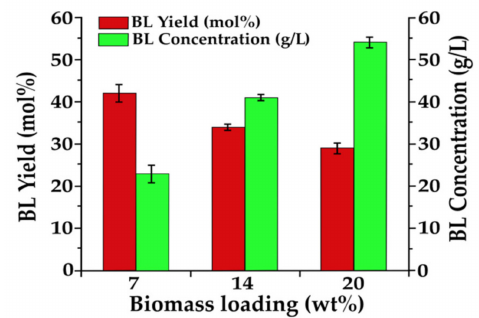
Figure 5. One-pot MW-assisted butanolysis of the ADW Eucalyptus nitens sample to BL, adopting di ff erent biomass loadings (7, 14, and 20 wt%). Reaction conditions: 190 ◦ C, 15 min, H 2 SO 4 1.2 wt%, MW heating.